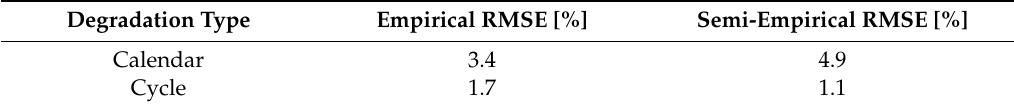
Table 3. Maximum root mean square error [%] for both empirical and semi-empirical models.